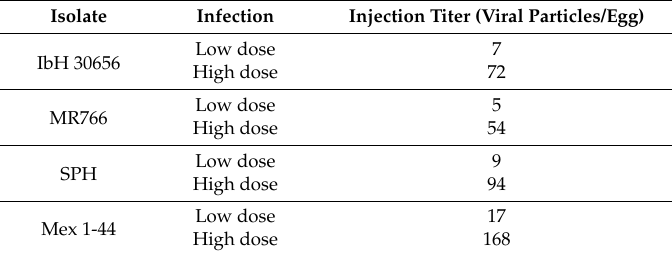
Table 4. ZIKV particles injected per embryonated egg.